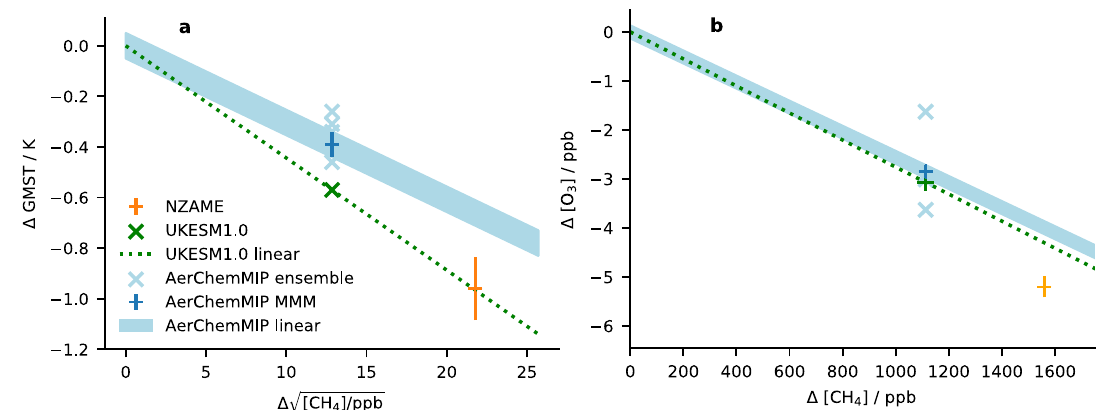
Fig. 4 Comparison of ZAME and AerChemMIP ozone and temperature changes with respect to methane concentration. AerChemMIP results are shown in blue, the UKESM ensemble member in green and ZAME in orange. Linear trends are extrapolated to test linearity of ZAME with respect to AerChemMIP. a Difference in global mean surface temperature ( Δ GMST) vs the difference in square root of methane p ffiffiffiffiffiffiffiffiffiffiffi (cid:2) ½ CH ) for 2015 – 2050, according to the relationship between methane concentration and radiative forcing 34 . b Difference in concentration ( Δ 4 ozone concentration ( Δ